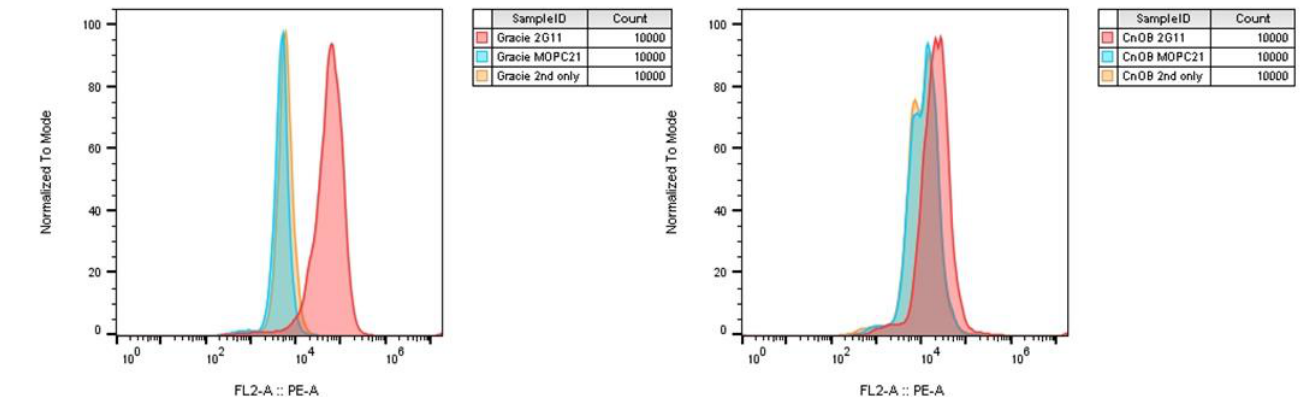
Figure 4. Flow cytometry histograms. Left : Gracie (canine OS cell line) binding intensity is signif- icantly greater for 2G11 antibody (targeting IGF2R) compared to MOPC21 control and secondary antibody alone. Right : Non-neoplastic canine osteoblasts (CnOb cell line) have 2G11 binding com-